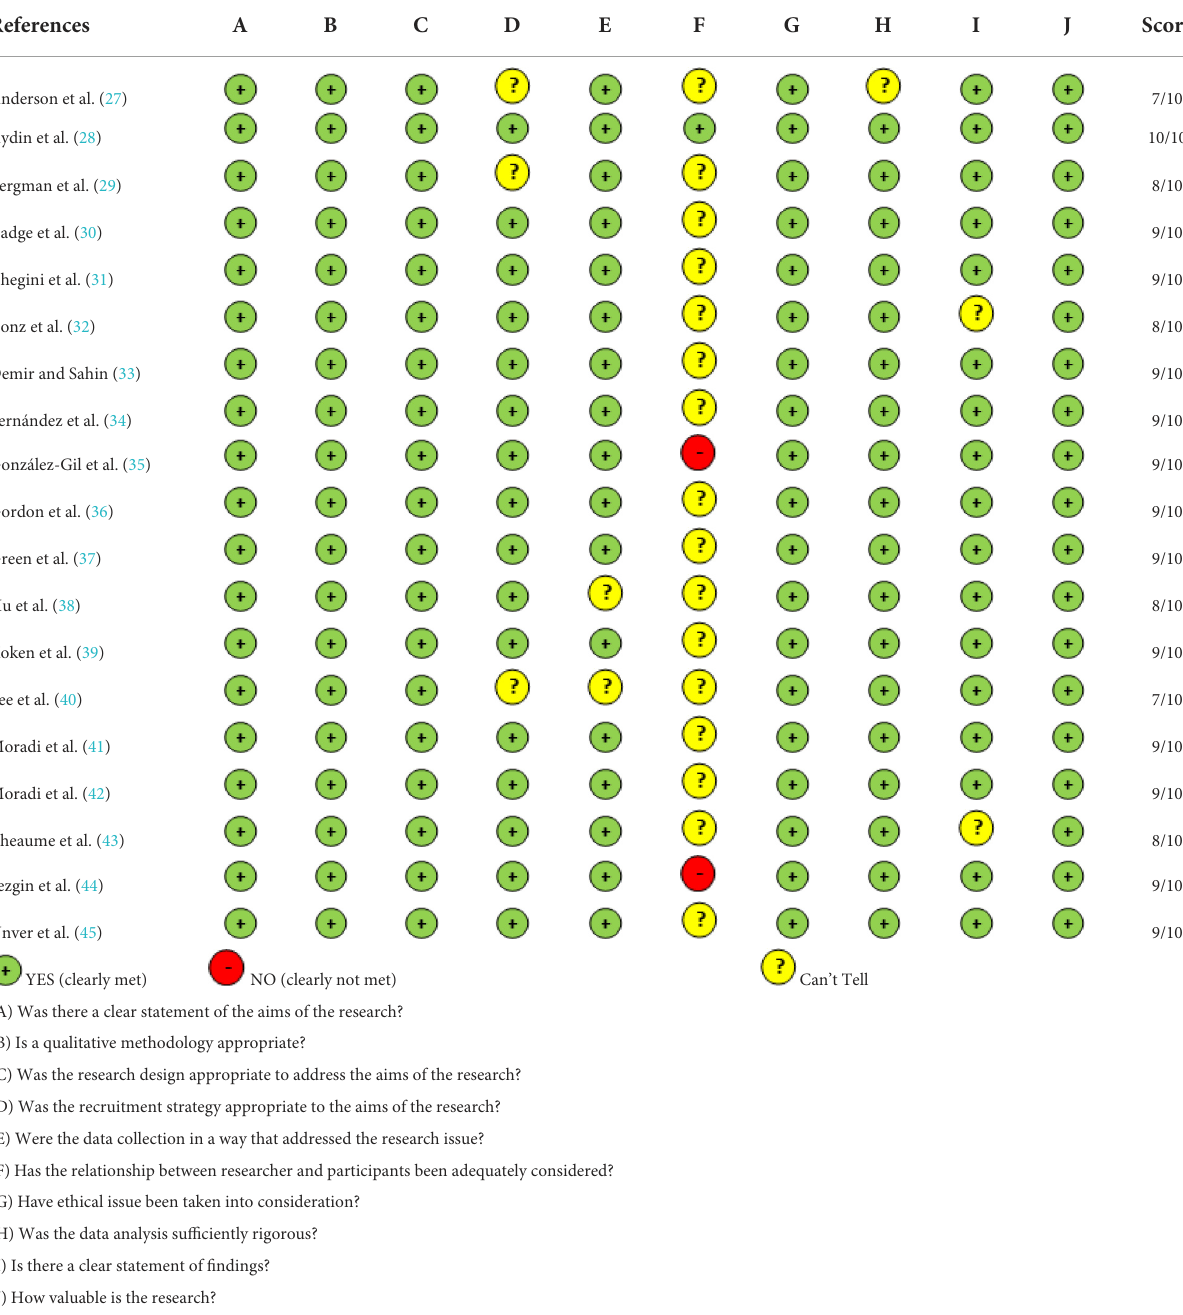
TABLE 1 Critical appraisal skills program (CASP)